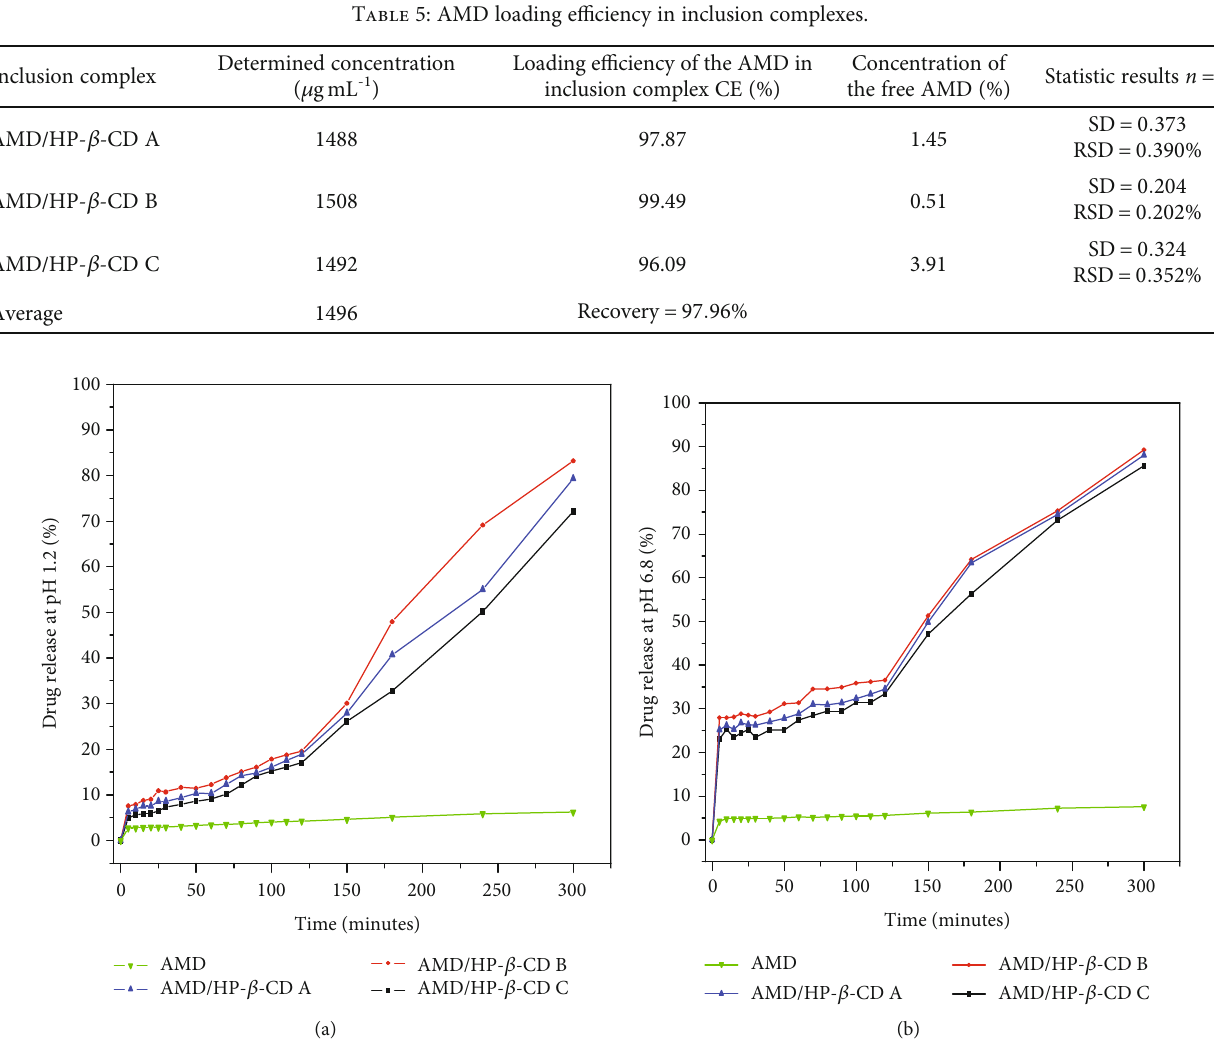
Figure 14: Release pro fi les of AMD at (a) pH 1.2 and (b) pH 6.8 from the inclusion complexes comparatively with the AMD solubility